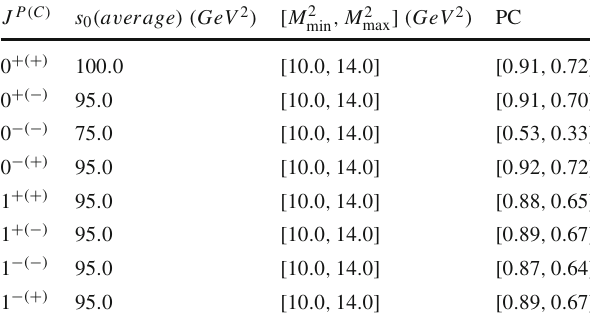
Table 3 Values of PC for different quantum numbers of the ground state bottom-nonstrange hybrid mesons